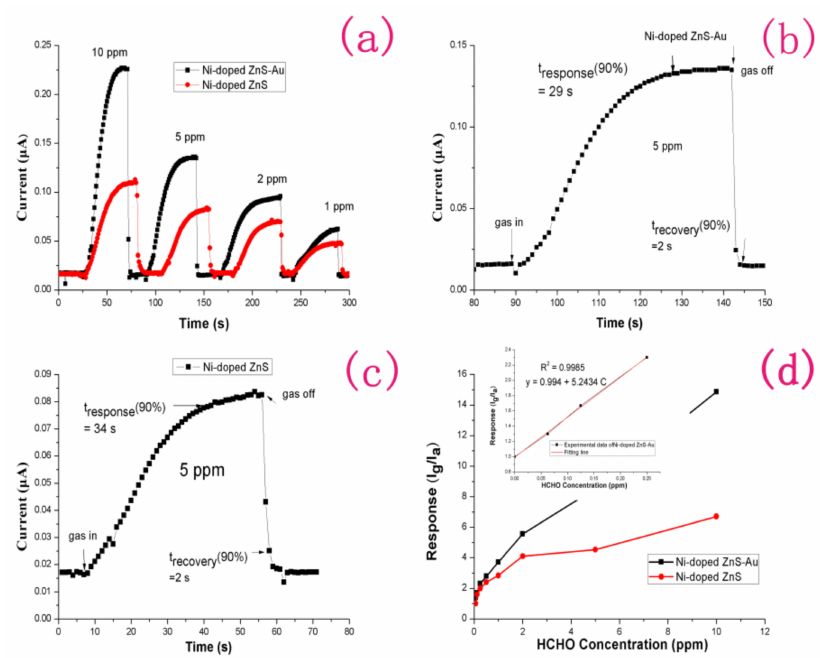
Figure 3. ( a ) Dynamic response of the gas sensors based on Ni-doped ZnS nanospheres and Au-decorated Ni-doped ZnS nanospheres at room temperature. ( b ) Enlarged part of ( a ) for the gas sensor based on